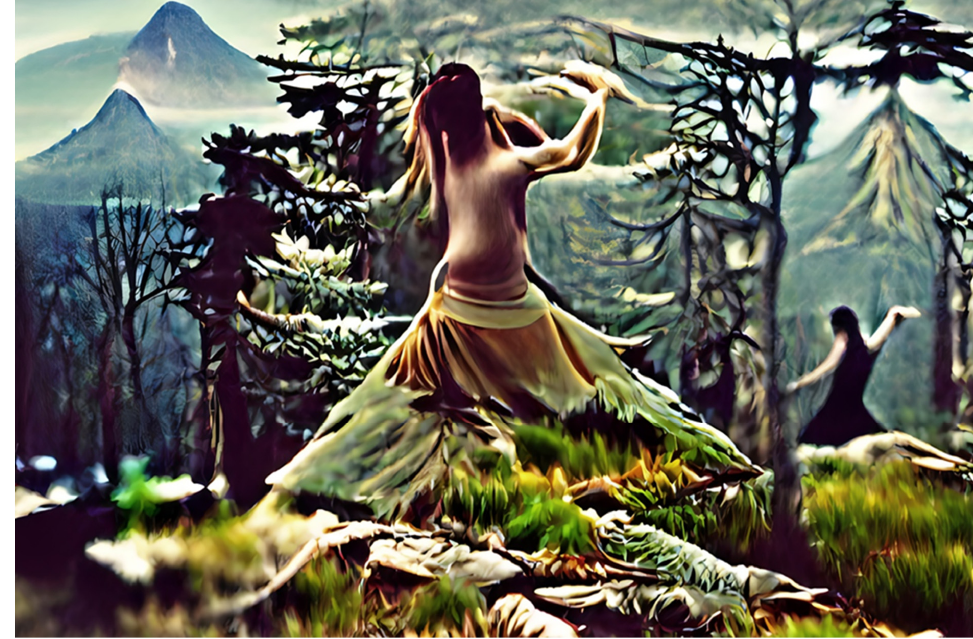
Figure 7. Madeleine + Body, mountain, forest. By Graeme Revell, 2022. Photograph, GPT-2/DALL-E2 image and text.